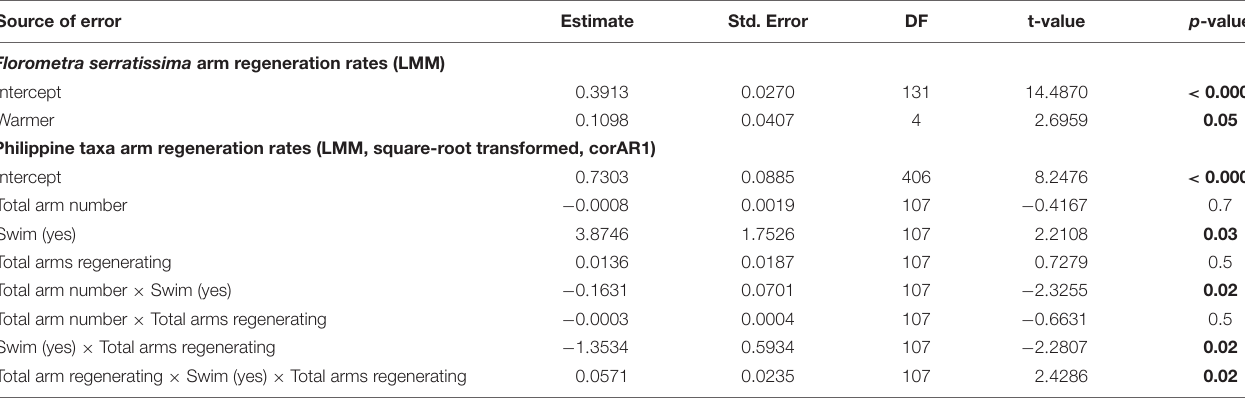
TABLE 4 | Results of the optimal, most parsimonious Linear Mixed Model testing for independent and interactive effects of warming ( Florometra serratissima only), total arm number and ability to swim (Philippine species only) on crinoid arm regeneration. Source of error